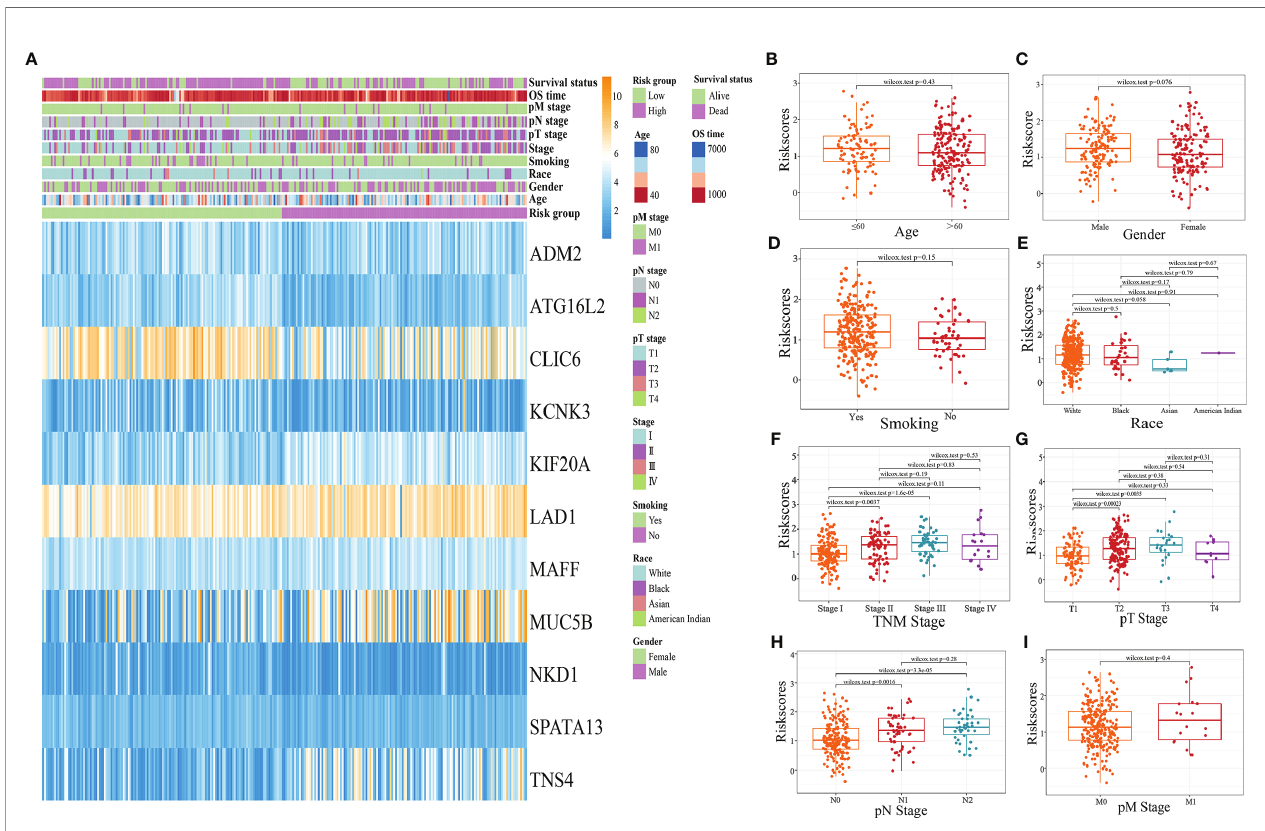
FIGURE 8 | Clinicopathological characteristics of different risk score subgroups. ( A : heat map of clinicopathological characteristics of different risk score subgroups; B : the relationship between age and risk score; C : the relationship between sex and risk score; D : the relationship between smoking history and Riskscore; E : the relationship between race and Riskscore; F : the relationship between pathological TNM stage and Riskscore; G : the relationship between pathological T stage and Riskscore; H ;. Relationship between pathological N-stage and Riskscore; I : Relationship between pathological M-stage and